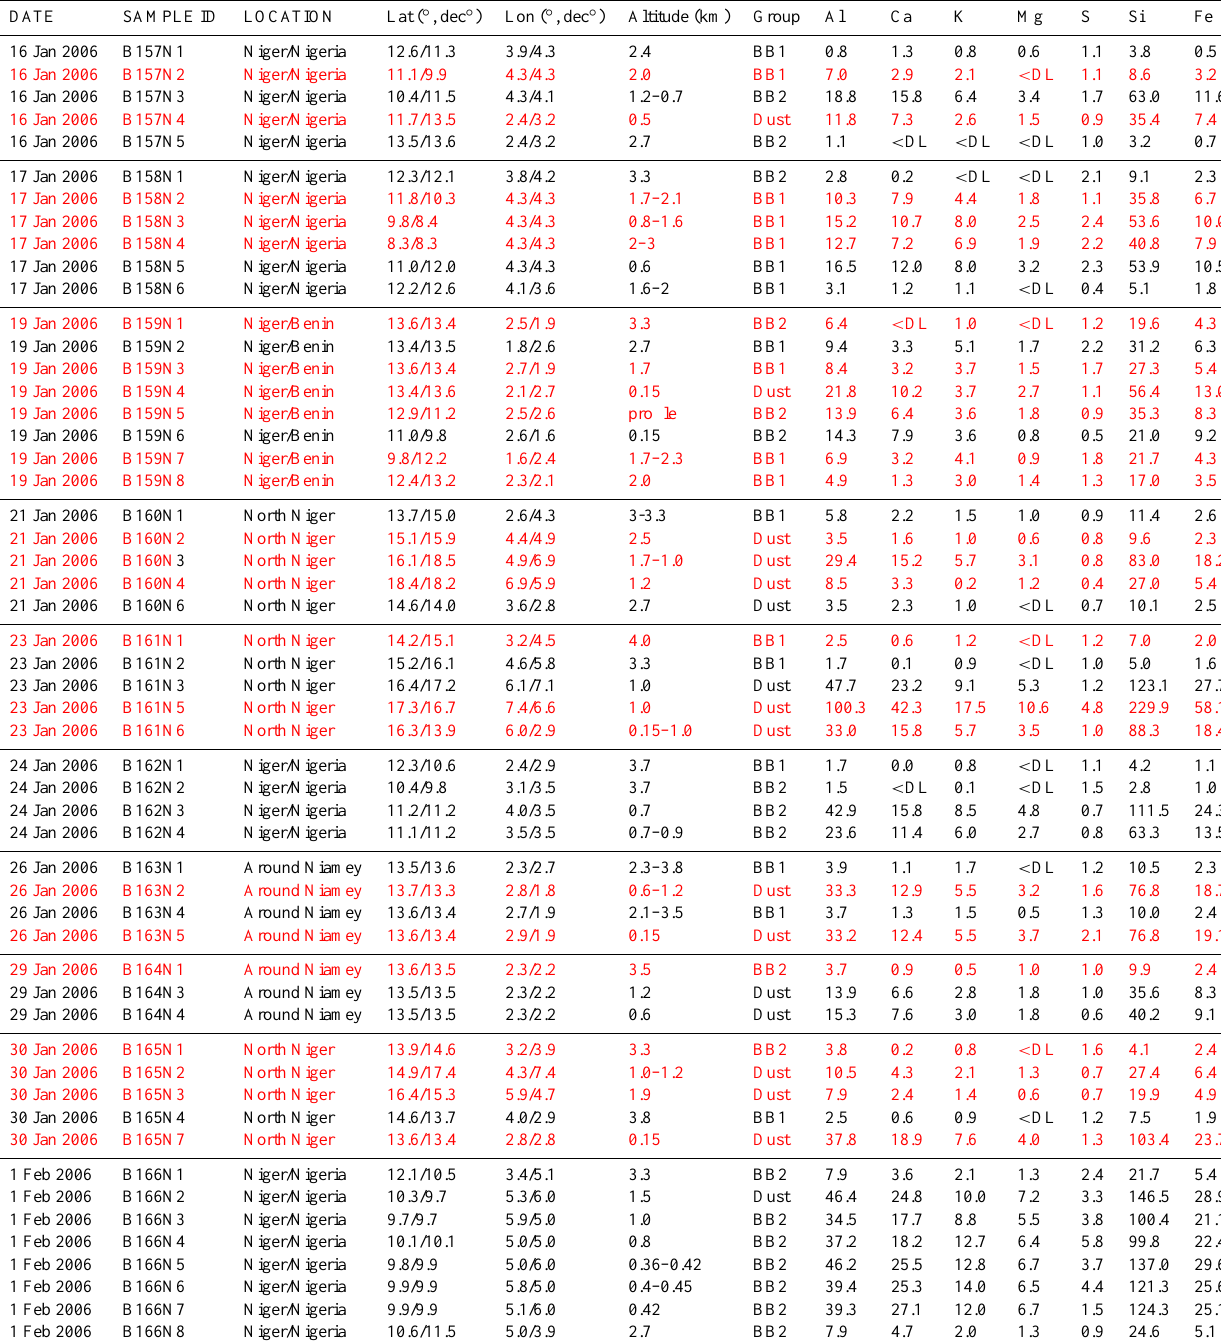
Table 1. Sample Identification and Main Operational Details for the Sampled Filter (for lon/lat: start/end sampling) (Note: PIXE measure- ment, Al, Ca, K, Mg, S, Si, and Fe in µgm − 3 ). Red: Samples used for the determination of the